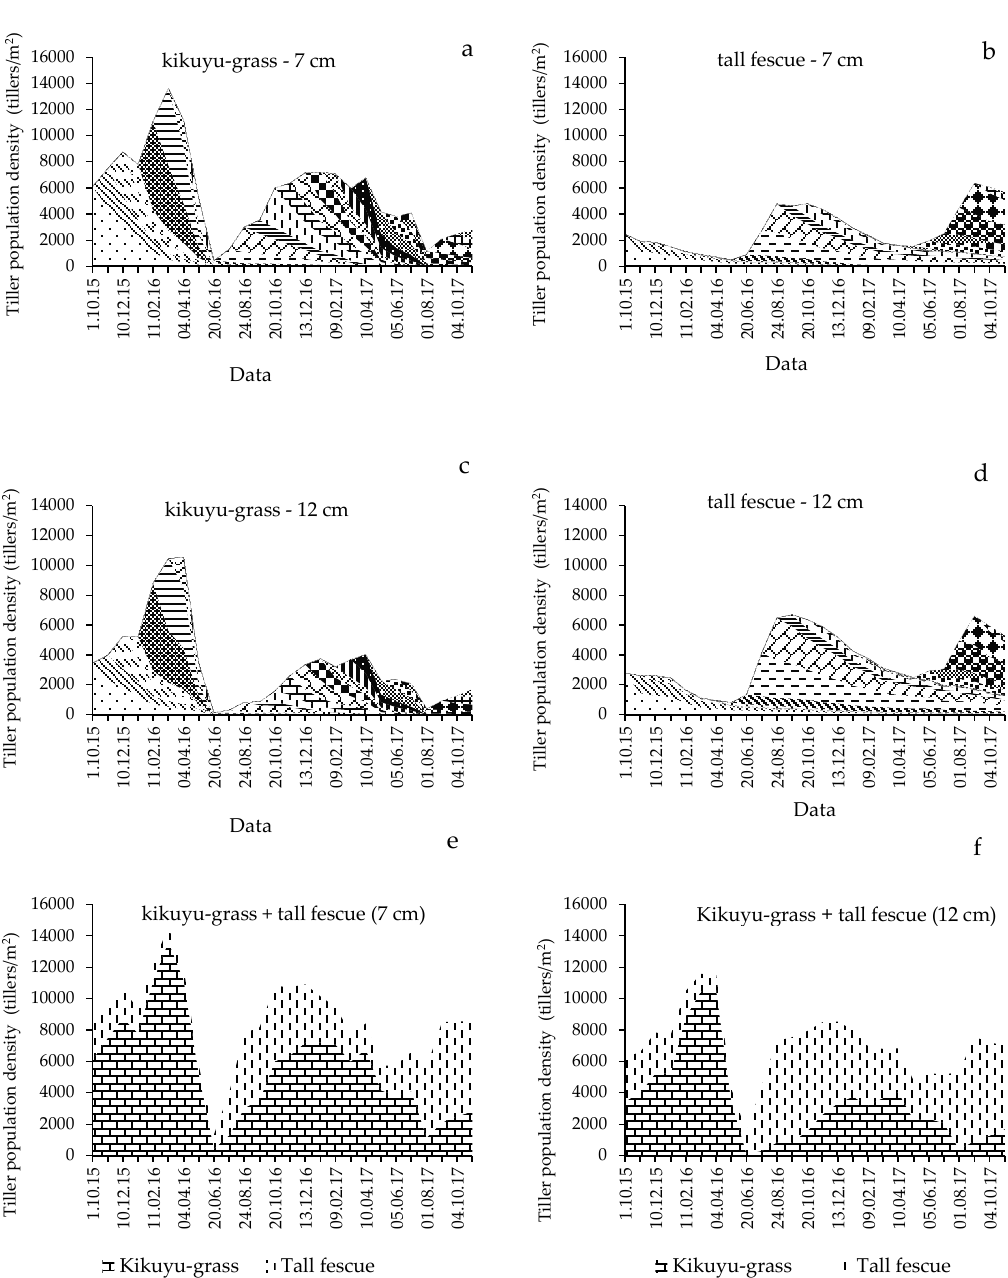
Figure 2. Cohort survival diagrams for tillers of kikuyu-grass ( a, c ) and tall fescue ( b, d ) cultivated in mixed canopies maintained at 7 and 12 cm and their overlapping population demography ( e, f ).